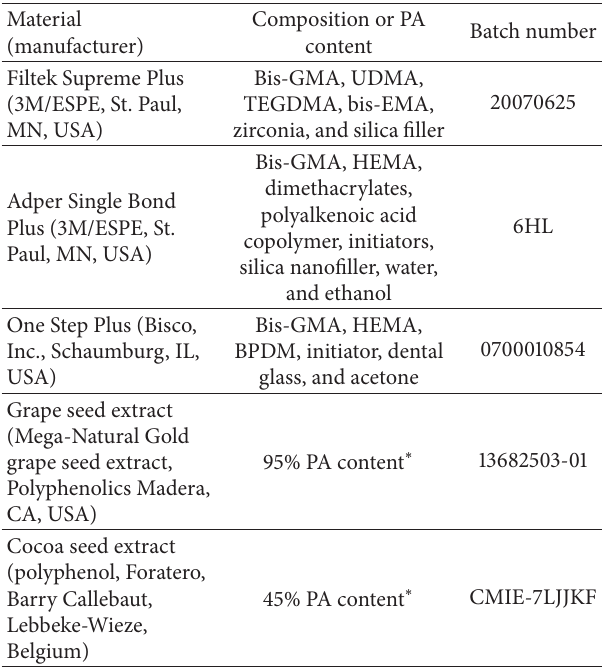
Table 1: Composition and batch numbers of used